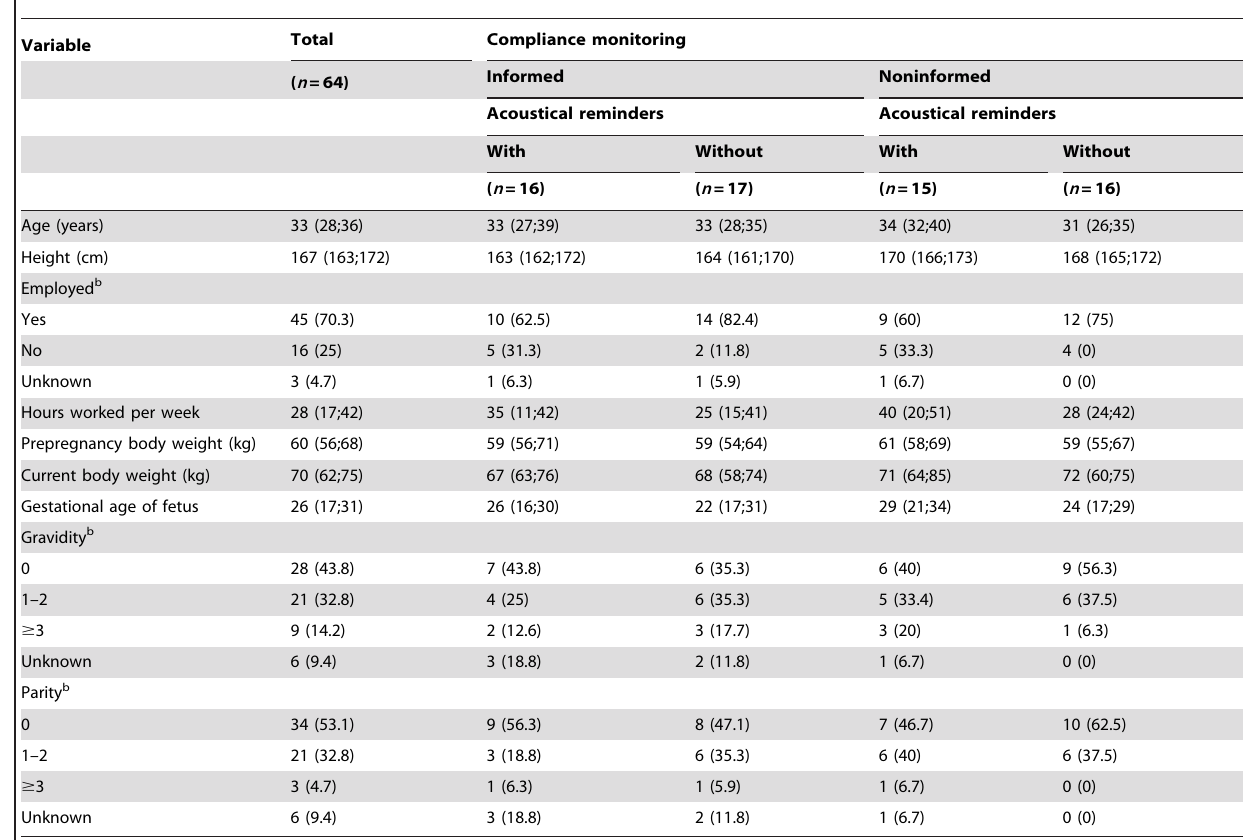
Table 1. Demographic variables a across experimental